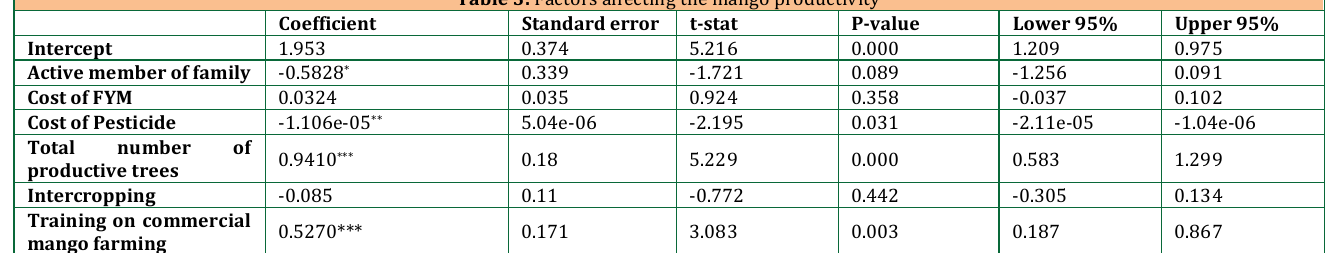
Table 3: Factors affecting the mango productivity